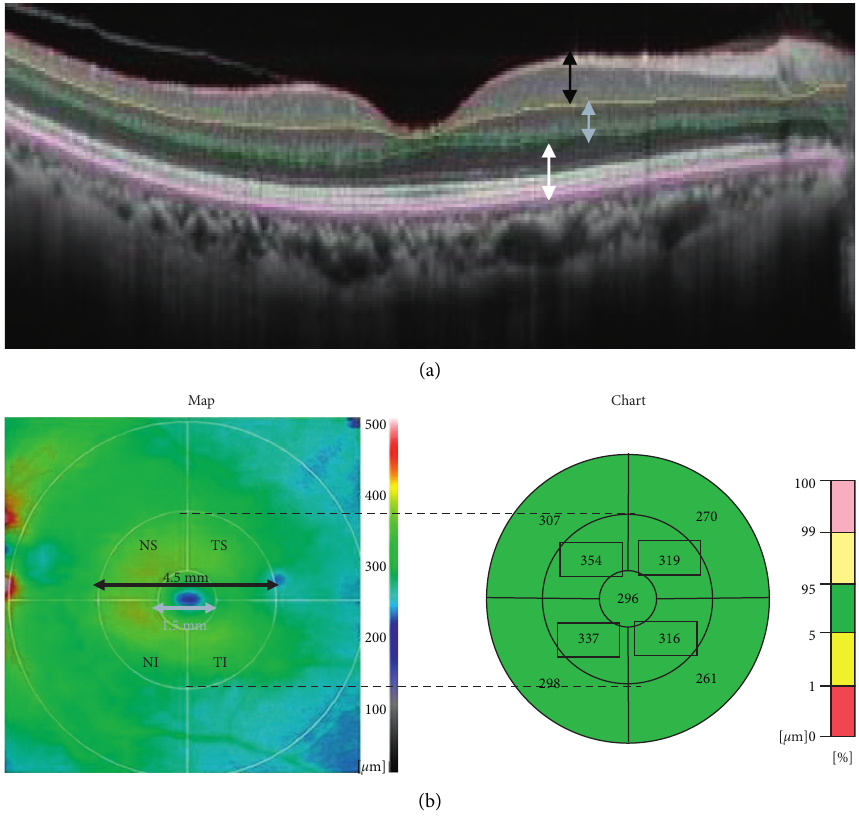
Figure 1: Cross-sectional images obtained by SD-OCT showing how measurements of the retinal thickness of the inner (black arrow), middle (gray arrow), and outer retinal layers (white arrow) were made. (a) Retinal thickness map of the inner retinal layer. (b) Inner and middle circles of 1.5 and 4.5mm diameters were placed on the center of the fovea. Averaged thicknesses for the temporal/superior (TS), temporal/inferior (TI), nasal/superior (NS), and nasal/inferior (NI) quadrants of the middle circle are presented in the thickness chart (encompassed by squares). SD-OCT, spectral-domain optical coherence